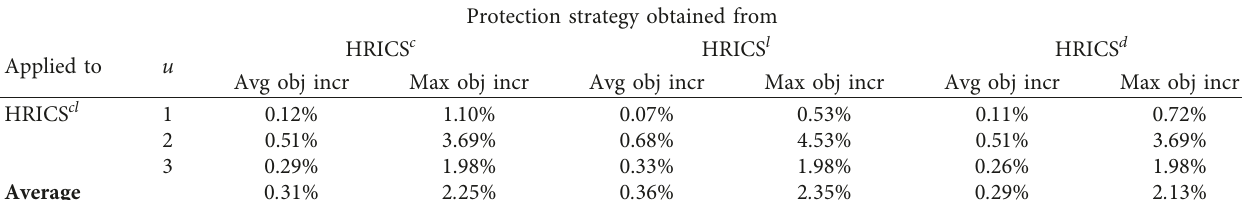
Table 5: Relative cost increment when solutions from HRICS c , HRICS l , and HRICS d are applied to HRICS cl . Protection strategy obtained from